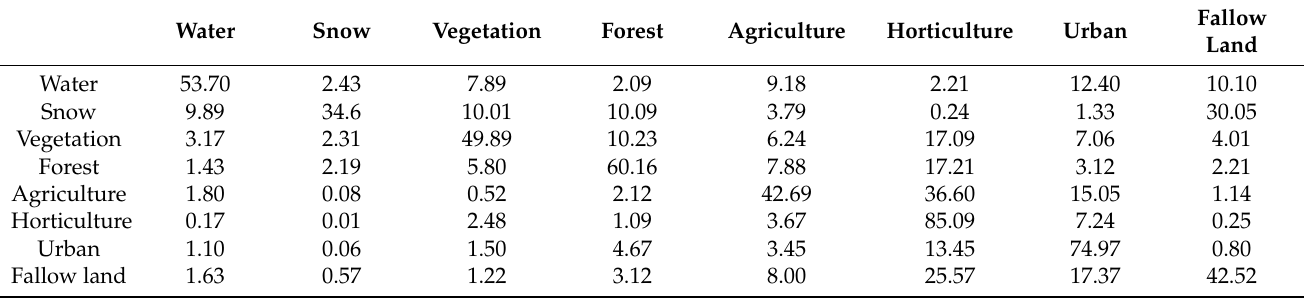
Table 10. Transfer Probability matrix during 2010–2020 (km 2